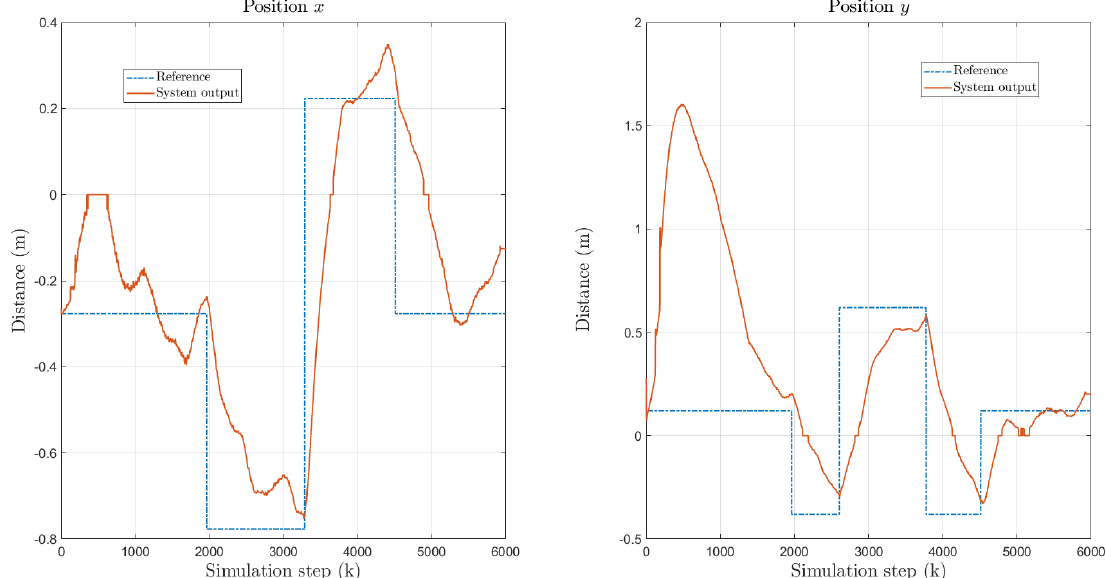
Figure 8. First simulation experiment with random initial weights. Dashed line represents the desired value and solid lines represent the system output. As can be seen, overshoot is reduced after some iterations.